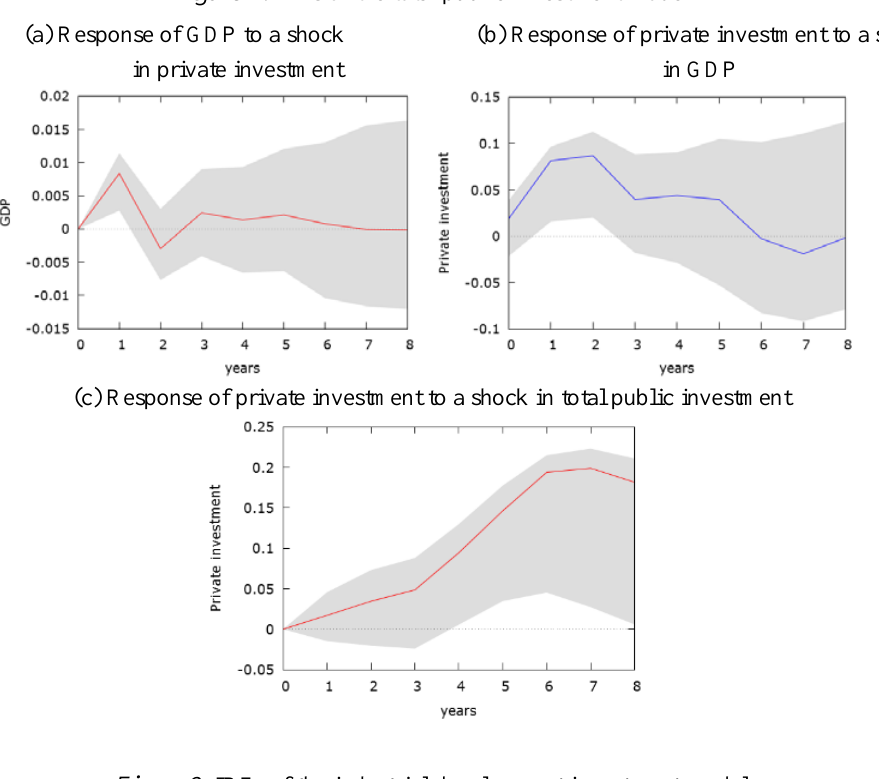
Figure 1 : IRFs of the total public investment model